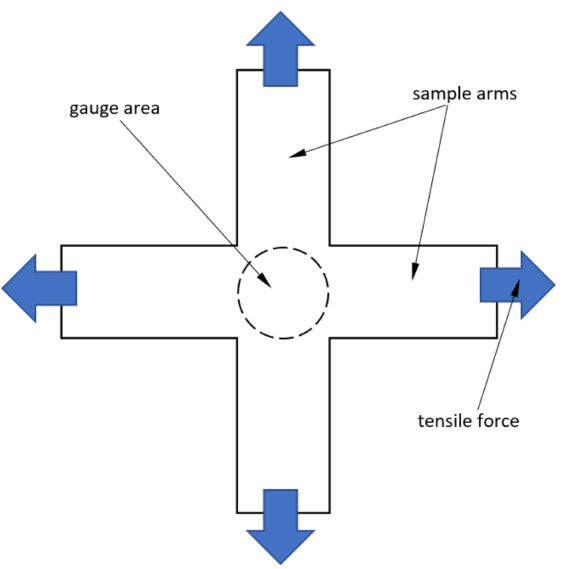
Figure 1. Schematic description of theoretical loading of a cruciform sample subjected to biaxial